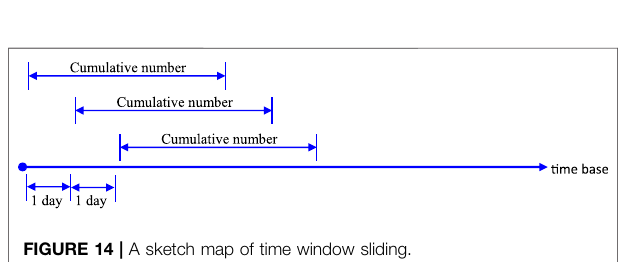
FIGURE 14 | A sketch map of time window sliding.